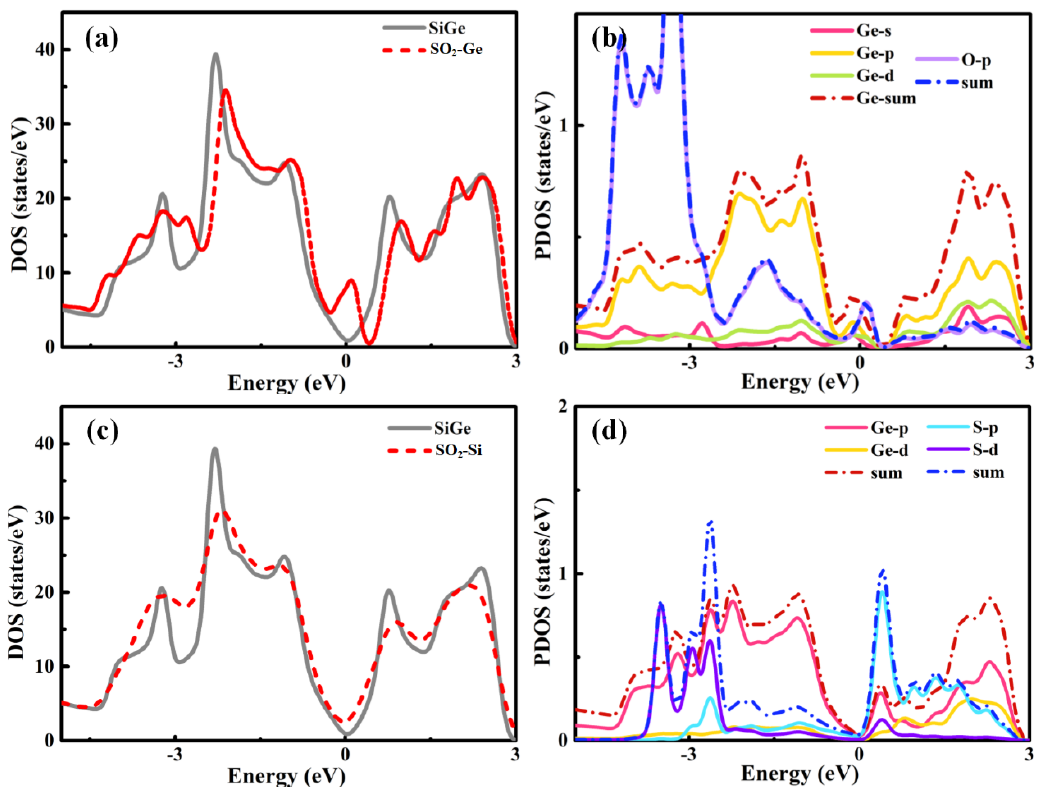
Figure 3. Total and partial density of states for ( a ), ( b ) SO 2 -Ge and ( c ), ( d ) SO 2 -Si adsorptions.